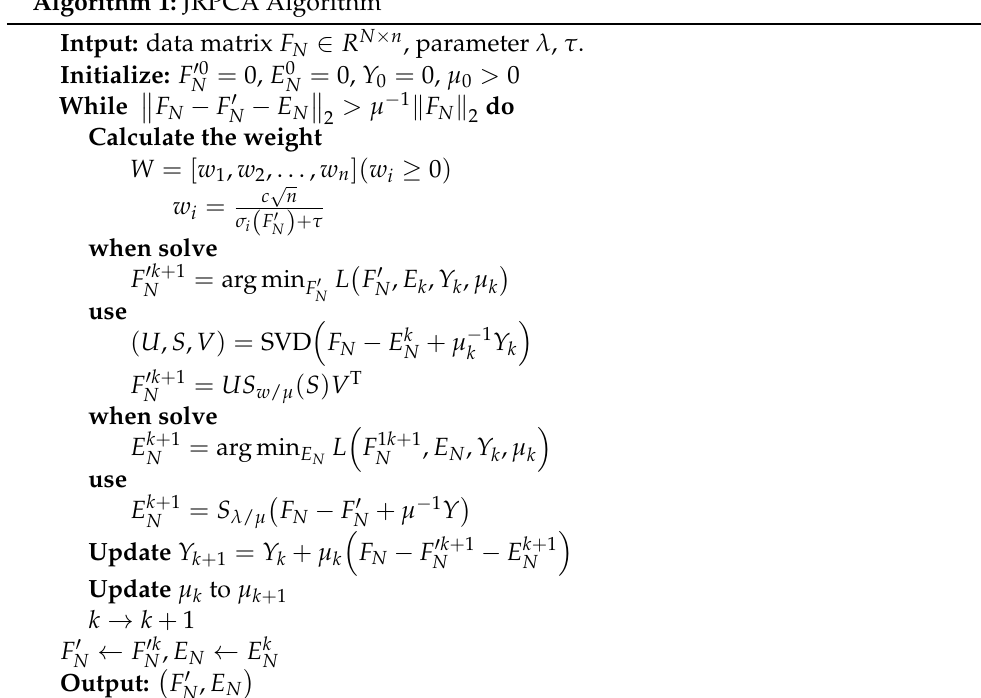
Algorithm 1: JRPCA